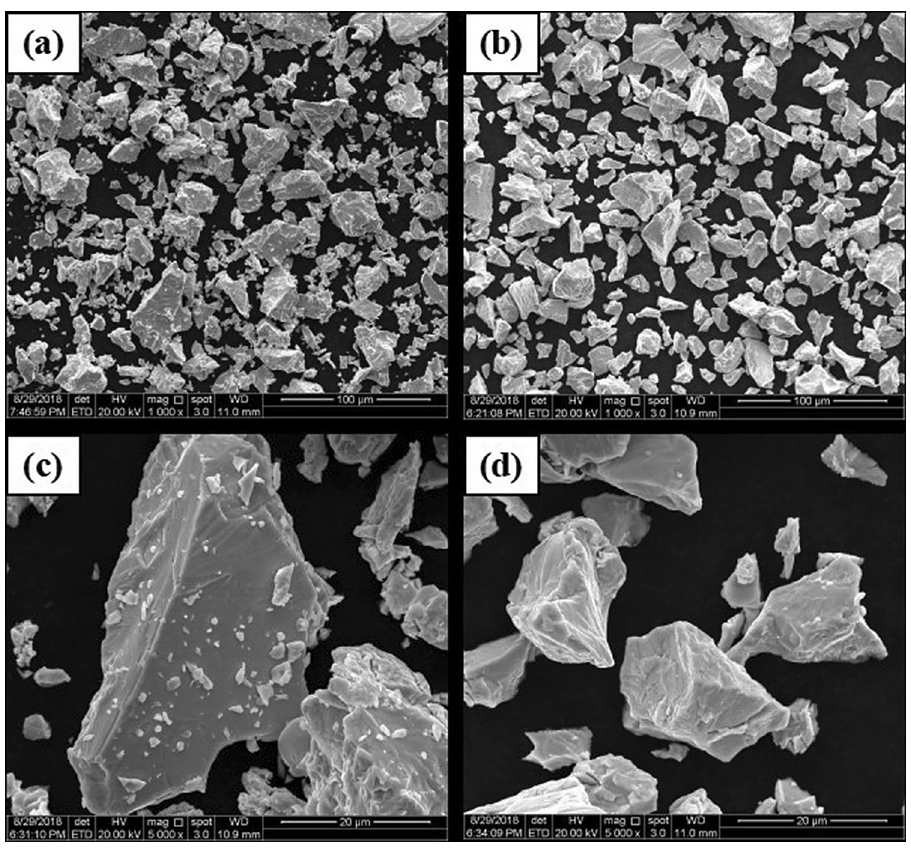
Figure 10. SEM images of niobium powder before and after oxygen reduction: ( a ) low rate before oxygen reduction, ( b ) low rate after oxygen reduction, ( c ) high rate before oxygen reduction, and ( d ) high rate after oxygen reduction.